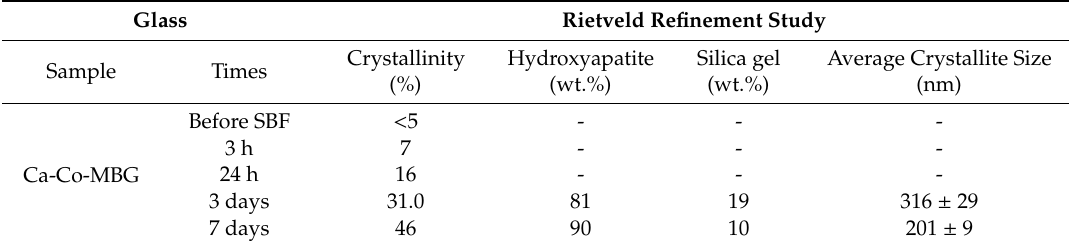
Table 4. Summary of the results of Rietveld refinement study for Ca-Co-MBG. Glass